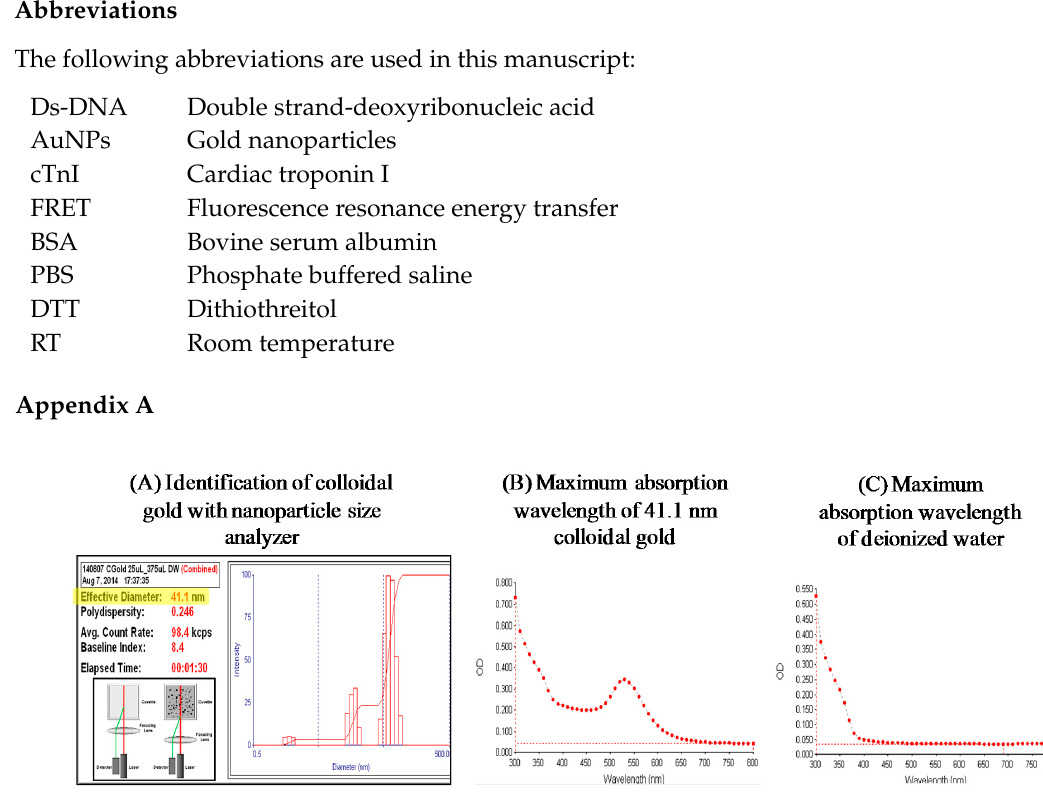
Figure A1. Synthesis of gold nanoparticles of uniform size and characterization of their size and maximum wavelength. The particles were generated using the citrate reduction method and had an effective diameter of ~41.1 nm ( A ). The maximum absorption wavelength of the particles was ~530 nm by comparison of the absorbance spectrum ( B ) with that of deionized water ( C ).